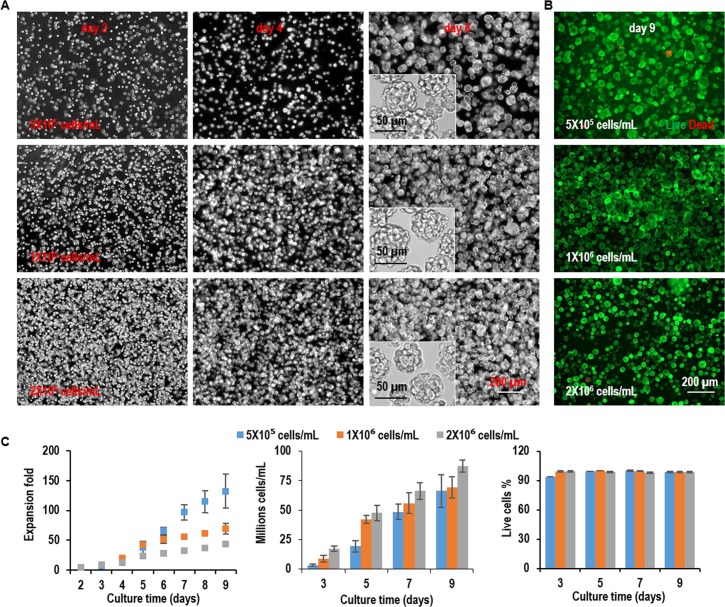
Culture L-Wnt-3a-cells in 3D PNIPAAm-PEG hydrogels (Passage 1).L-Wnt-3a-cells were cultured in the hydrogels with three seeding densities: low (5x105 cells/mL), medium (1x106 cells/mL), and high density (2x106 cells/mL). (A) Phase images of the passage 1 cells in the hydrogels on day 2, 4, 6 and 8 of the culture. (B) Live (green) dead (red) staining of day 9 cells in the hydrogels in passage 1. (C) The expansion fold, volumetric yield and cell viability along a 9-day culture in passage 1. Error bars represent the standard deviation (n = 3).